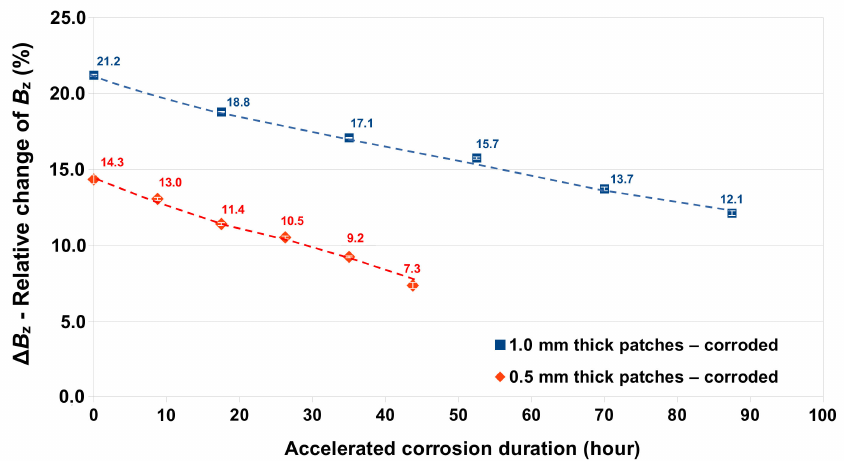
Figure 15. Relative change of B z , measured from the 3D-magnetometer, as a function of the acceler- ated corrosion duration applied on 0.5 and 1.0 mm-thick